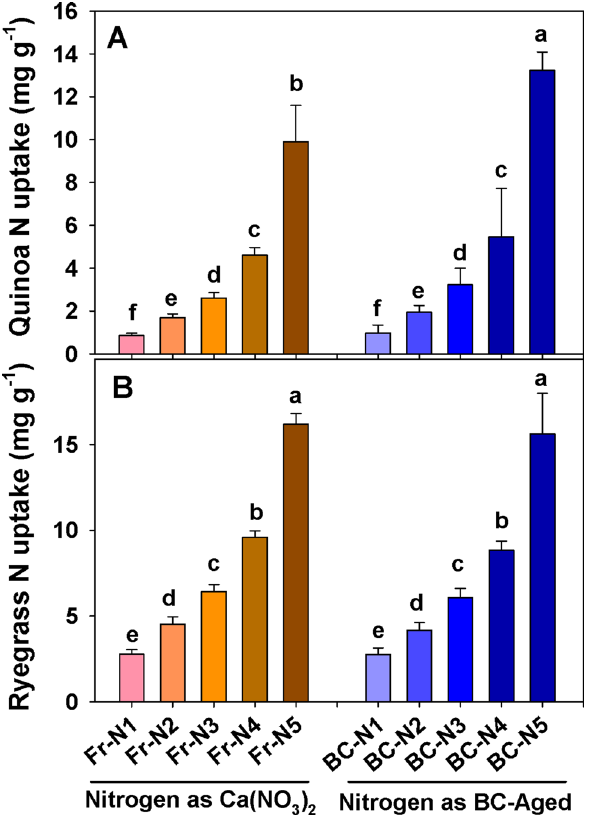
Figure 2. Effect of different nitrogen sources [(CaNO 3 ) 2 and N captured in BC-aged] and levels of N application (N-1 = 0, N-2 = 44, N-3 = 88, N-4 = 176 and N-5 = 352 kg ha −1 ) on N uptake in dry matter yield of quinoa and ryegrass (sum of two repeated cuttings at 30 days interval) under controlled conditions (means + s.d., n = 4). Note that the y-axis scales of ( A ) and ( B ) are different, based on the respective N uptake in dry matter yield of quinoa and ryegrass. Different letters on the bars indicate significant differences in the respective mineral N sources and levels following two-way ANOVA (Tukey test, P < 0.05).